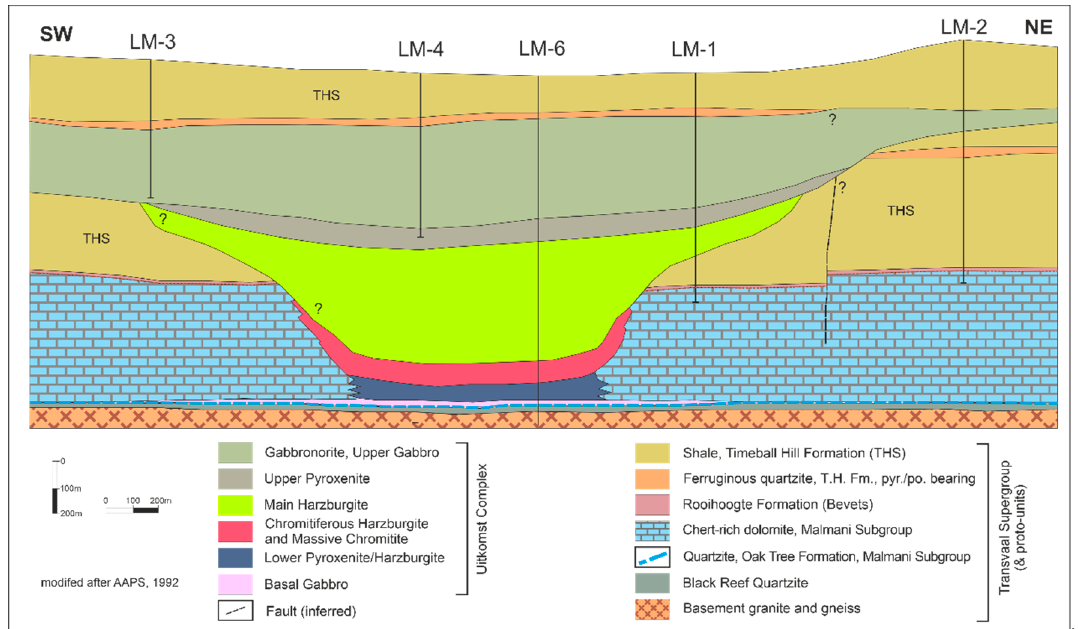
Figure 6. Approximate position of LM-6 in the SW-NE drill hole LM-1 to -4 line, the only borehole intersection of the entire complex on the farm LM and the inferred shape of the complex there; Abbreviations: pyr./po. = pyrite/pyrrhotite.